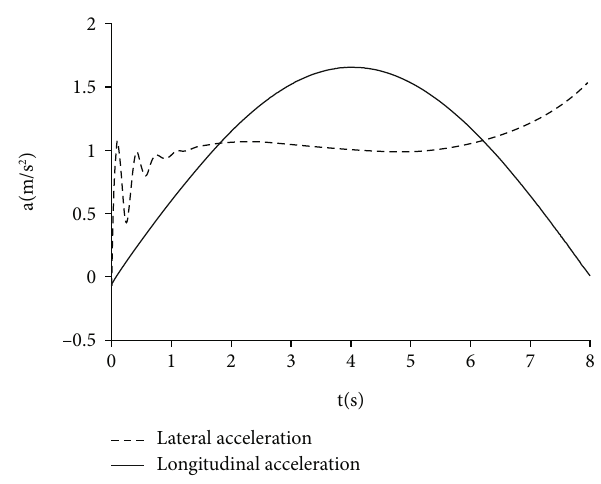
Figure 4: Acceleration